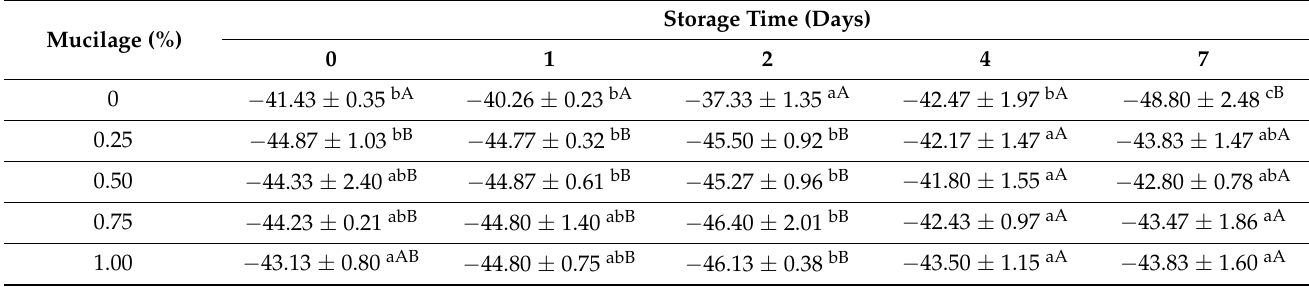
Table 2. Zeta potential (mV) of O/W emulsions containing different concentrations of C. olitorius mucilage during seven days of